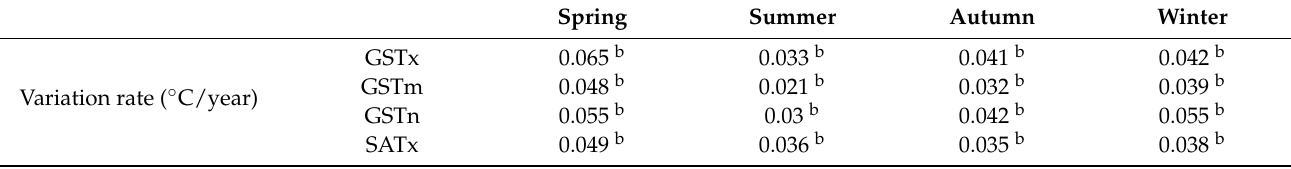
Figure 3. Annual averaged timeseries of ( a – c ) GST-, ( d – f ) SAT-, and ( g – i ) SATD-related indexes from 1980 to 2019 in Southwest China (a denotes significant at 0.05 level and b denotes significant at 0.01 level. Red dots denote climate jump. Slope denotes variation rate from 1980 to 2019). Table 3. Variation rate and climate jump of regional seasonal averaged GST-, SAT-, and SATD-related indexes in Southwest China during